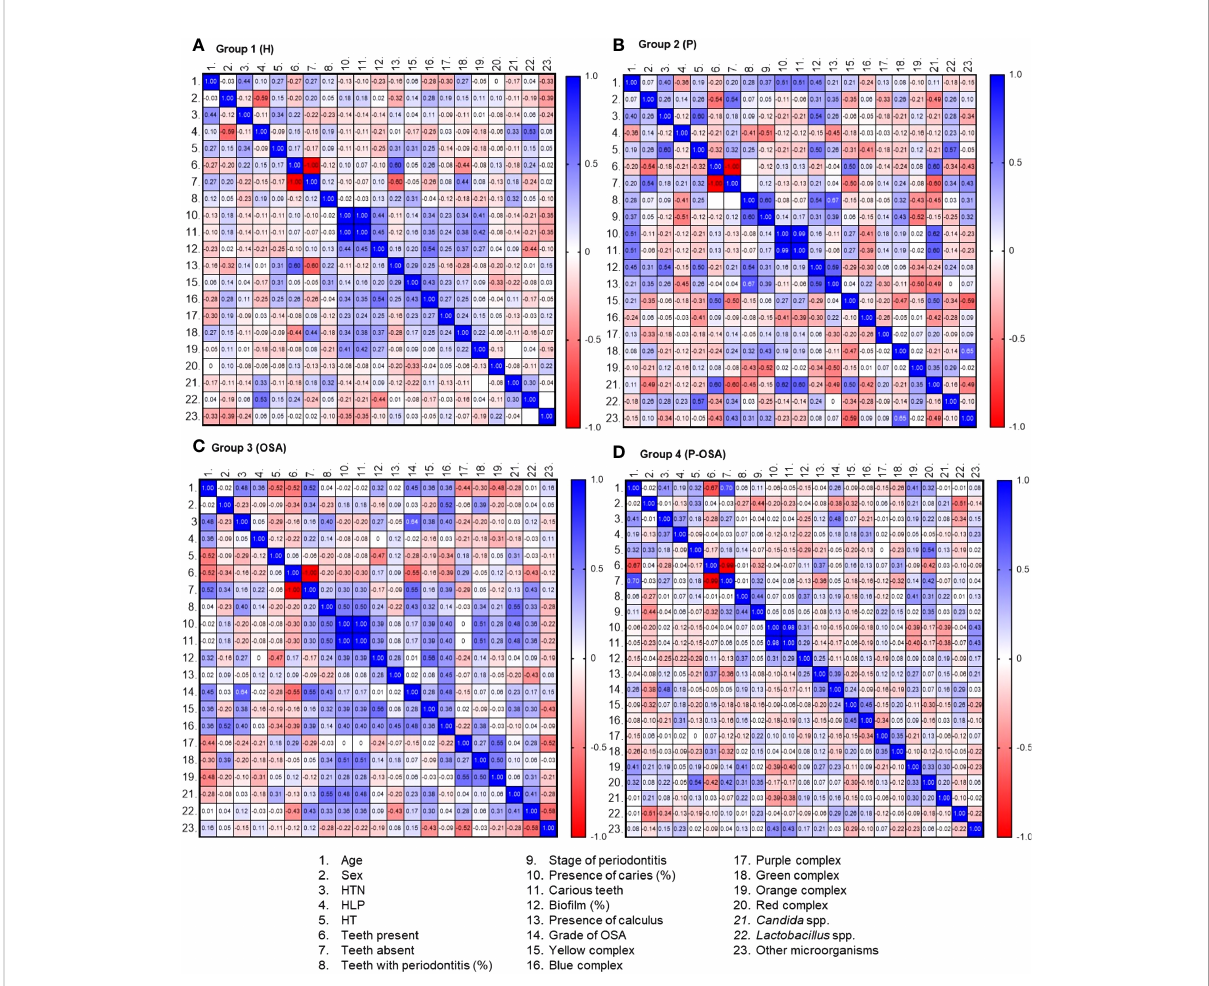
FIGURE 3 Multicomponent matrix for the correlation of clinical factors and complex/categories of microorganisms present in each of the groups of patients evaluated: (A) Group 1 (H), n = 25; (B) Group 2 (P), n = 17; (C) Group 3 (OSA), n = 19; (D) Group 4 (P-OSA), n = 32, using the Spearman's rank correlation coef fi cient rs > 0.30, p<0.05. The blue tones represent a positive correlation and the red tones represent a negative correlation. HTN, arterial hypertension. HLD, hyperlipidemia. HT: